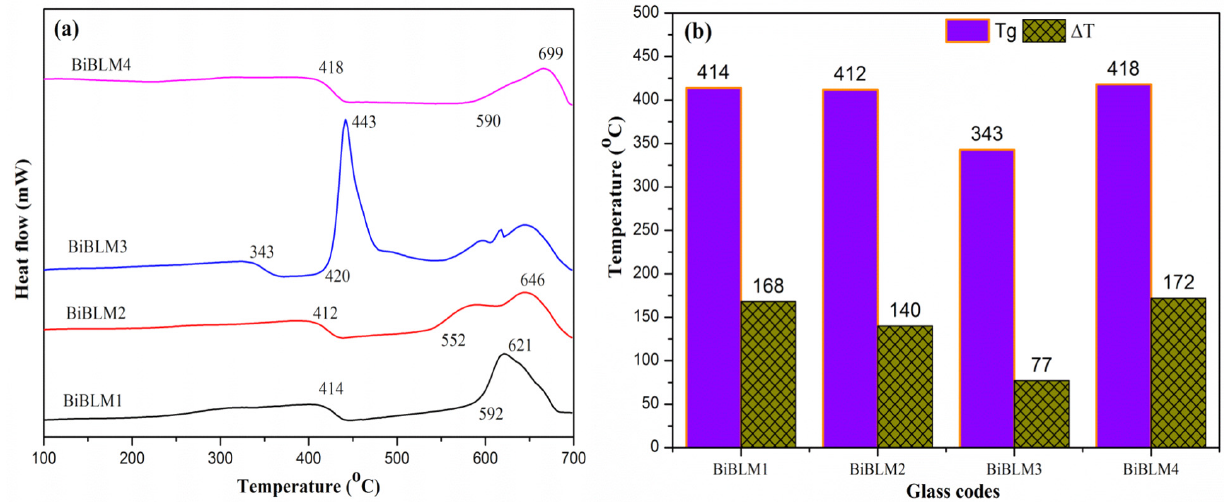
Figure 2. ( a ) DSC of BiBLM glass system; ( b ) compositional dependence of transition temperature (T g ) and thermal stability ( ∆ T) of BiBLM glass specimens. Table 2. DSC parameters of BiBLM glasses.